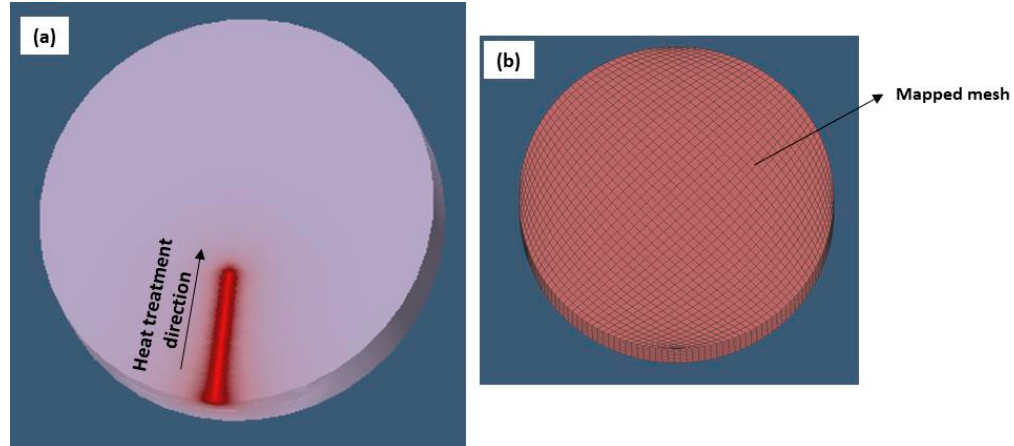
Figure 17. The temperature distribution in the heat treatment direction. ( a ): The temperature distribution in the hardening direction ( b ): The mesh used in the FEM simulation The model was validated comparing the thermal cycle (Figure 18) with CCT curves to predict the microstructures in the hardened zones of AISI 4130 steel. Based on the CCT diagram, at high cooling rates (v = 130 °C/s) a martensitic microstructure with retained austenite was observed. The CCT curve is shown in Figure 19 [46].